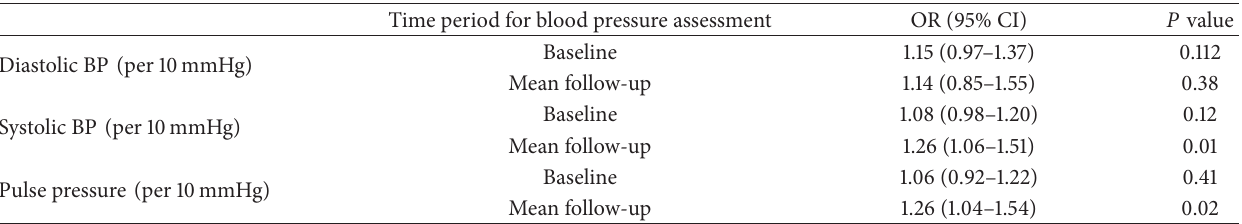
Table 3: Association of new incidence of LVH by year 4 with blood pressure (baseline, 𝑁 = 531 (110 events), mean follow-up, 𝑁 = 530 (110 events)).